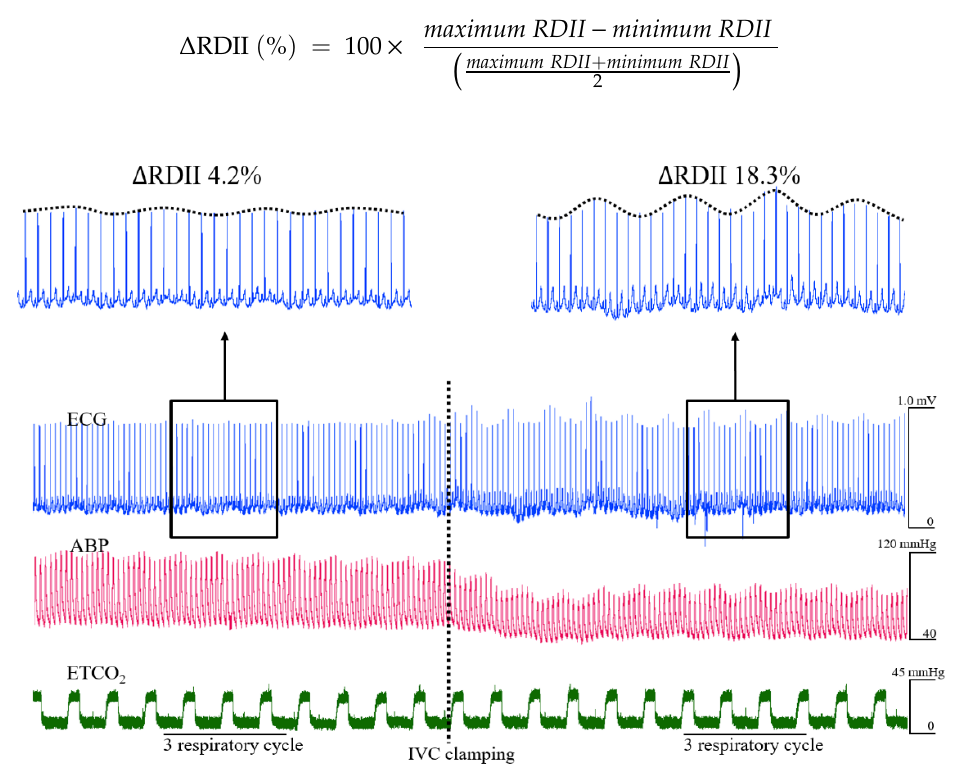
Figure 1. Representative plot of beat-to-beat changes to electrocardiogram (ECG) and arterial blood pressure (ABP) during inferior vena cava (IVC) clamping procedure. Accompanying an acute decrease in ABP, respiratory variation in ECG R-wave amplitude ( ∆ RDII) was markedly augmented. To calculate respiratory variations in RDII, three consecutive respiratory cycles before and after IVC clamping were selected.